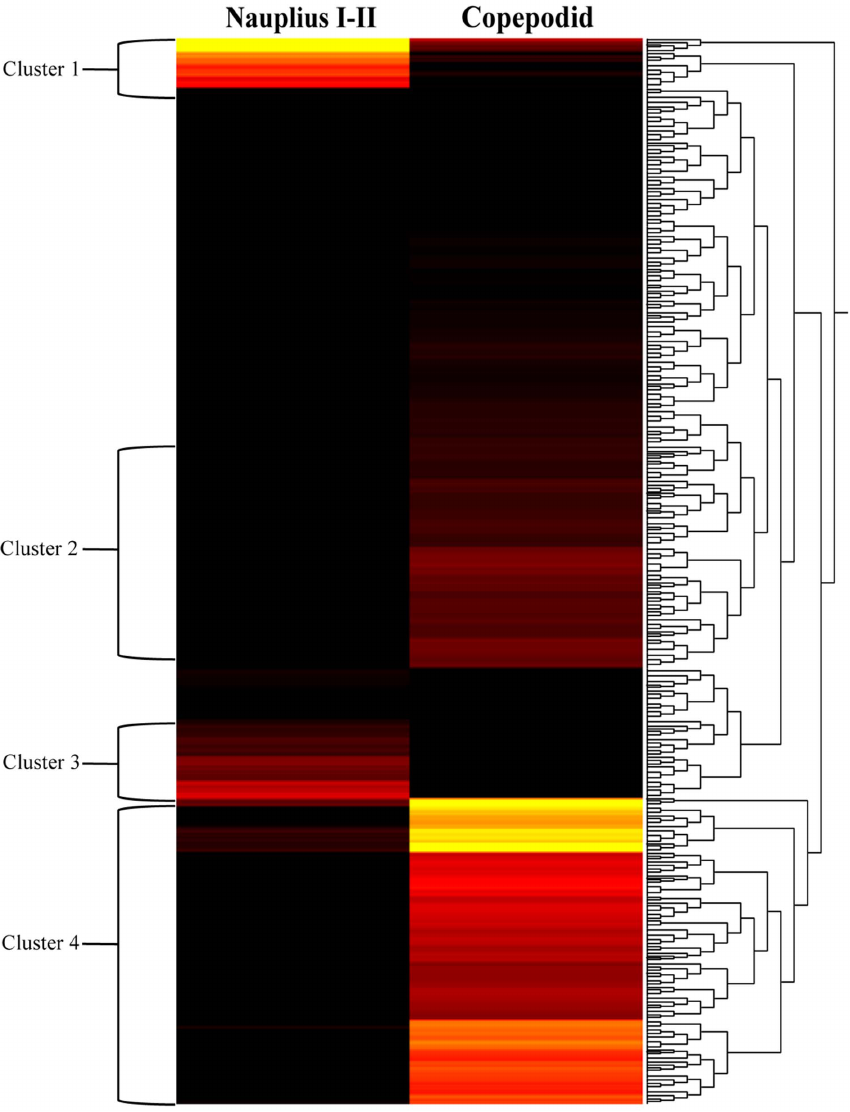
Figure 4. Clusters of gene expression levels between Nauplius I–II and copepodid stages of C.rogercresseyi . Dendrograms of the transcription patterns were estimated for 83,444 contigs generated by de novo assembling. The bar color reflects the gene expression level from black (low), red (medium) to yellow (high). Contig annotations of these 4 clusters are listed in Table S2.